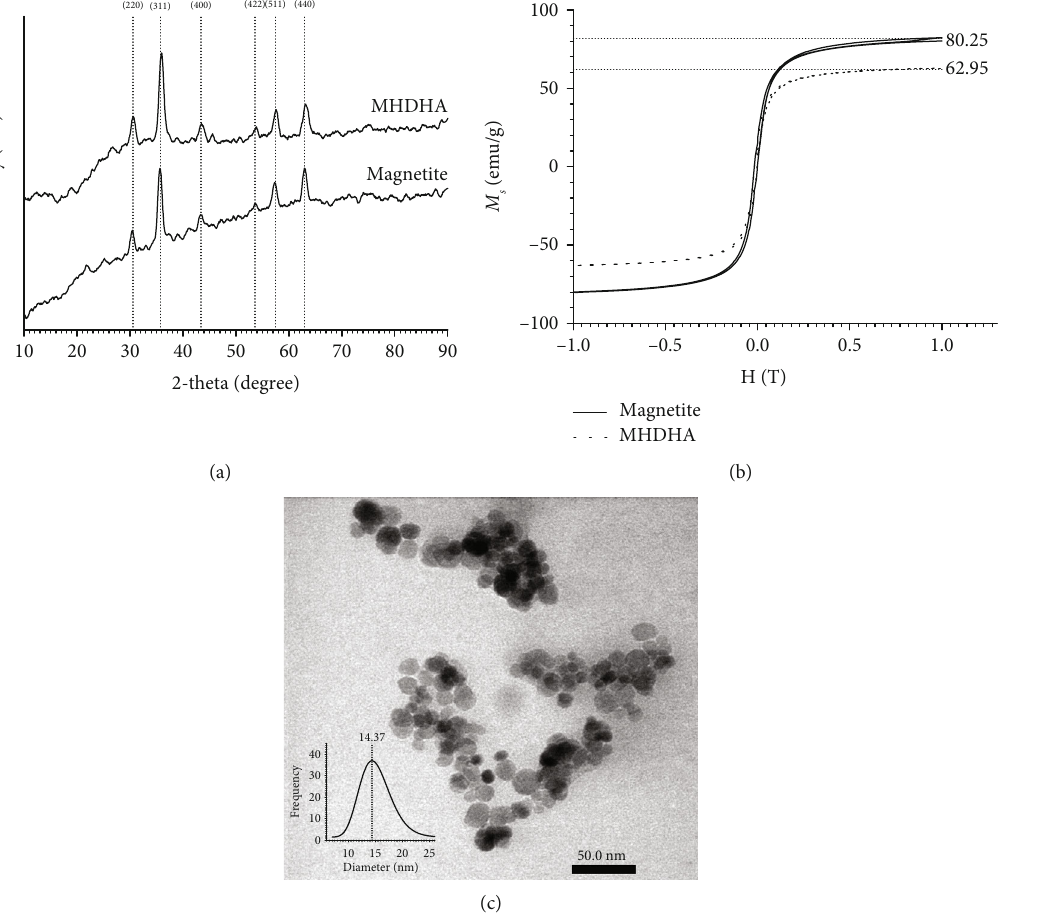
Figure 2: The di ff ractogram (a) and the magnetization hysteresis loop (b) of synthesized magnetite and MHDHA; TEM image of MHDHA and average particle size of MHDHA processed TEM image by free software ImageJ (inset picture) (c). Table 2: Elemental analysis by energy dispersive X-ray spectroscopy (EDX) of magnetite and